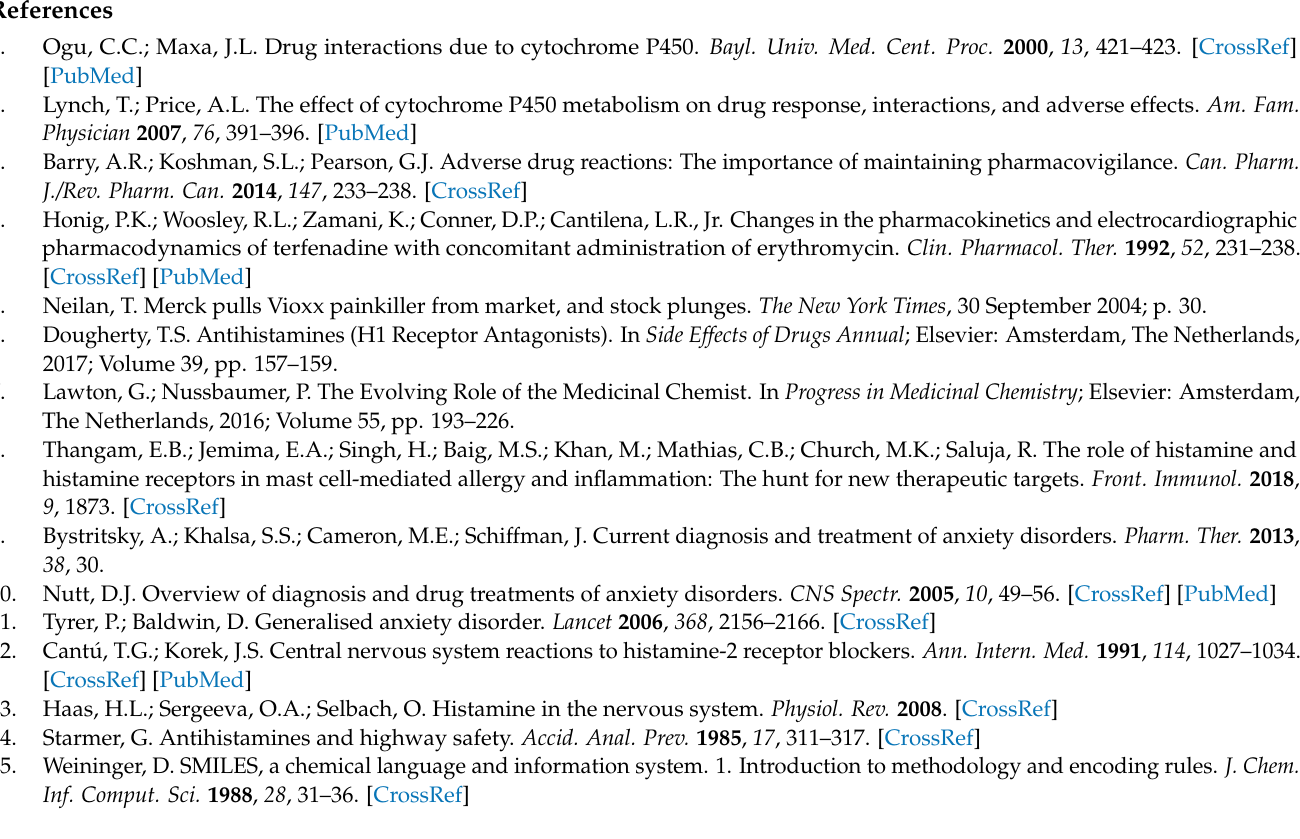
Table S2: SMILES training and testing data. Supplementary Table S3: SMILES and labels of experi- mental group data. Supplementary Table S4: Interaction types and features of the interactive drug pairs based on